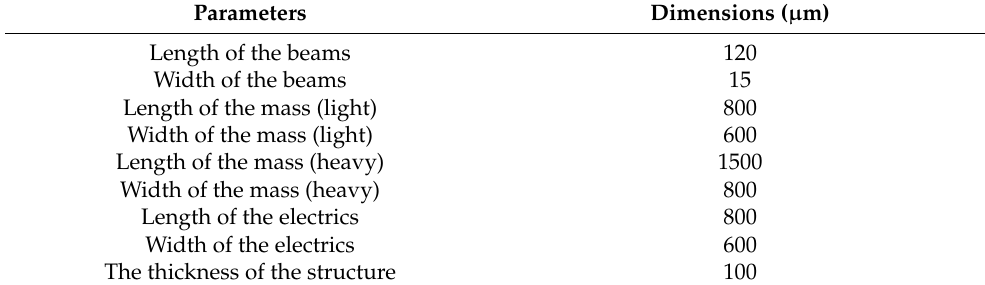
Table 1. The structural parameters of the teeter-totter accelerometer.